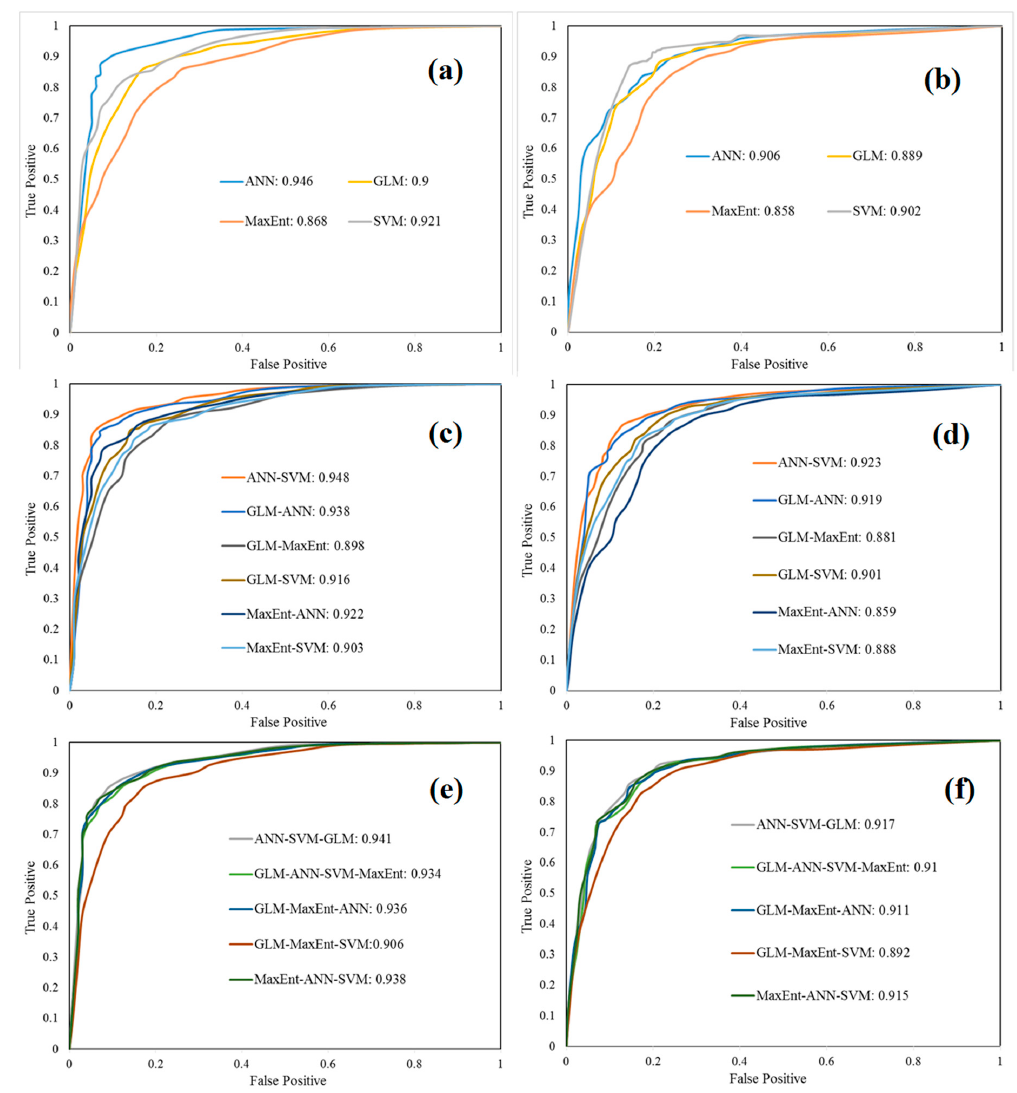
Figure 9. Area under the curves based on training datasets (success rate curve): ( a ) individual models, ( b ) ensemble of two models, ( c ) ensemble of three or four ensemble models based on validation datasets (prediction rate curve), ( d ) individual models, ( e ) ensemble of two models, and ( f ) ensemble of three or four ensemble models.